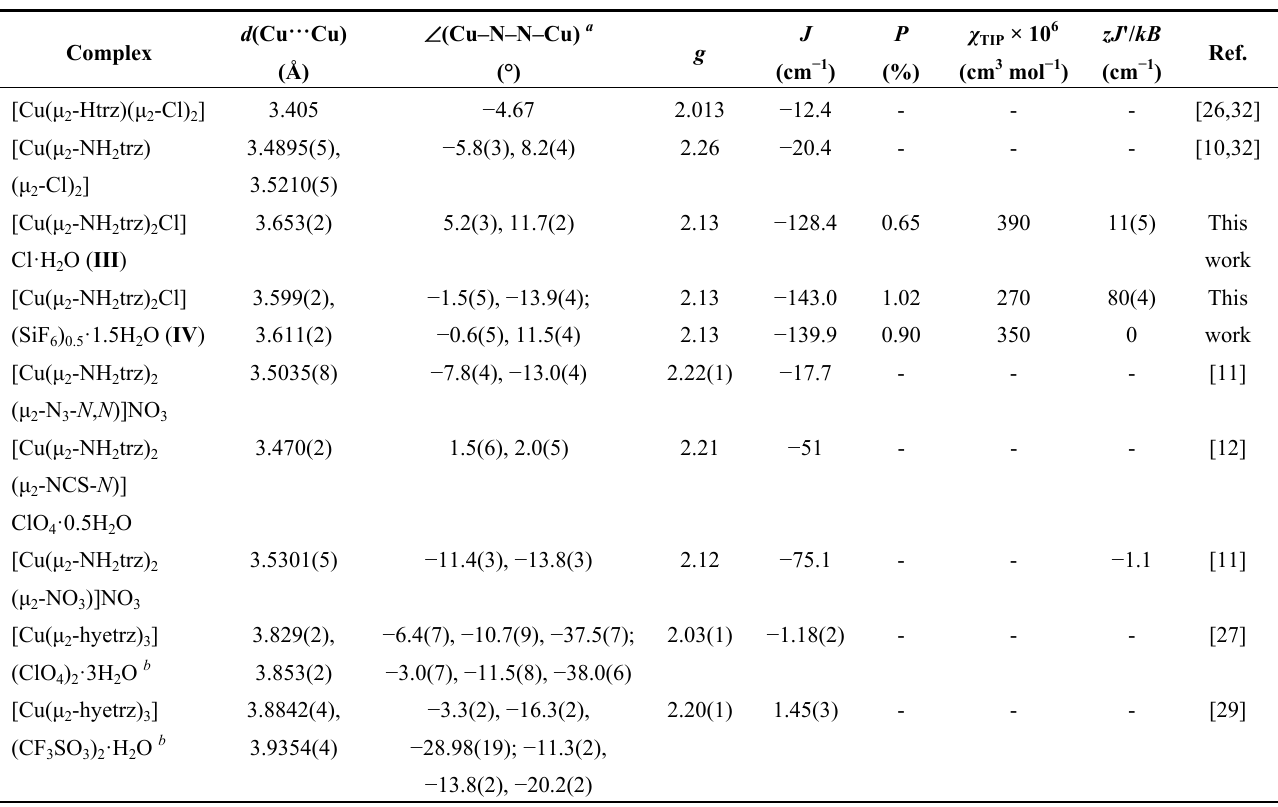
Table 1. Overview of structural characteristics and magnetic data for 1D Cu(II) chains with 1,2,4-triazole